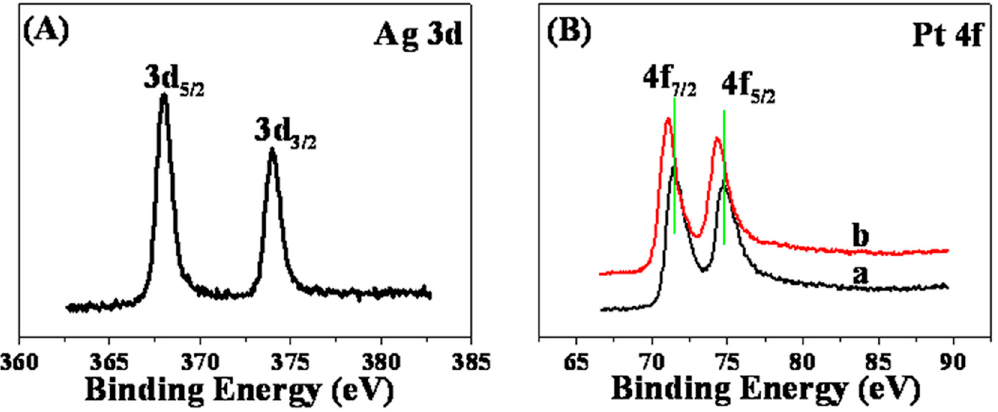
Figure 4. ( A ) Ag 3d X-ray photoelectron spectra (XPS) profile of Pt-Ag/GNs; ( B ) Pt 4f XPS profiles for Pt/GNs (a) and Pt-Ag/GNs (b).